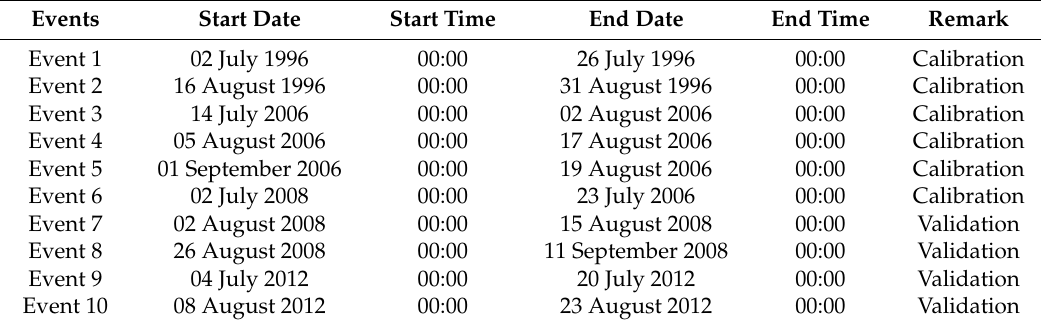
Table 1. Rainfall events selected for calibration and validation.